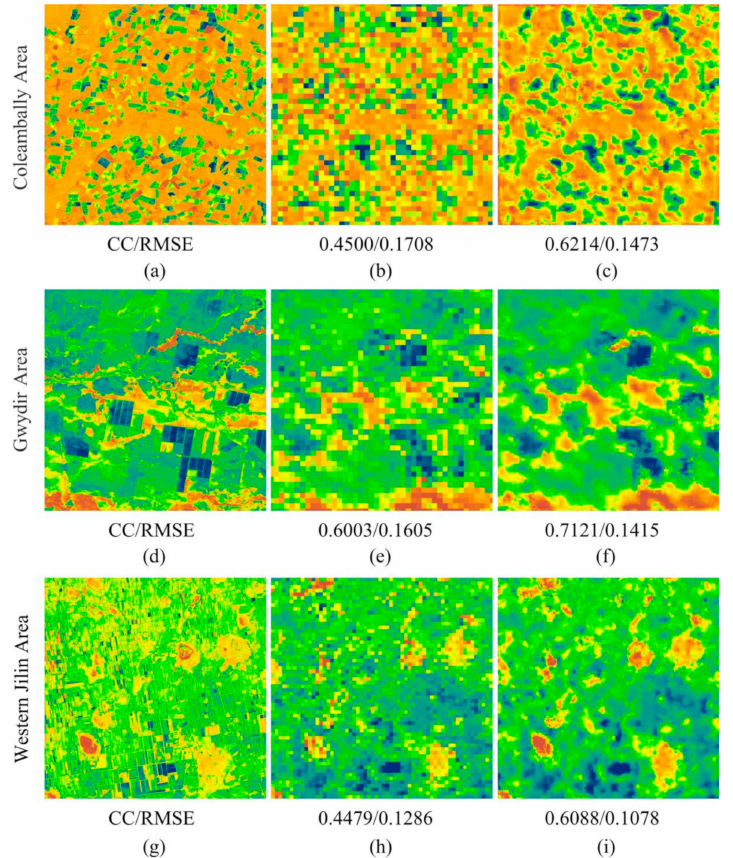
Figure 15. NDVI increment: ( a ) high-resolution NDVI increment ( ∆ F) in the Coleambally area, ( b , c ) corresponding low-resolution NDVI increment ( ∆ C) values before and after bias correction; ( d ) ∆ F for the Gwydir area, ( e , f ) corresponding low-resolution NDVI increment ( ∆ C) values before and after bias correction; ( g ) ∆ F for the western Jilin area, ( h , i ) corresponding low-resolution NDVI increment ( ∆ C) values before and after bias